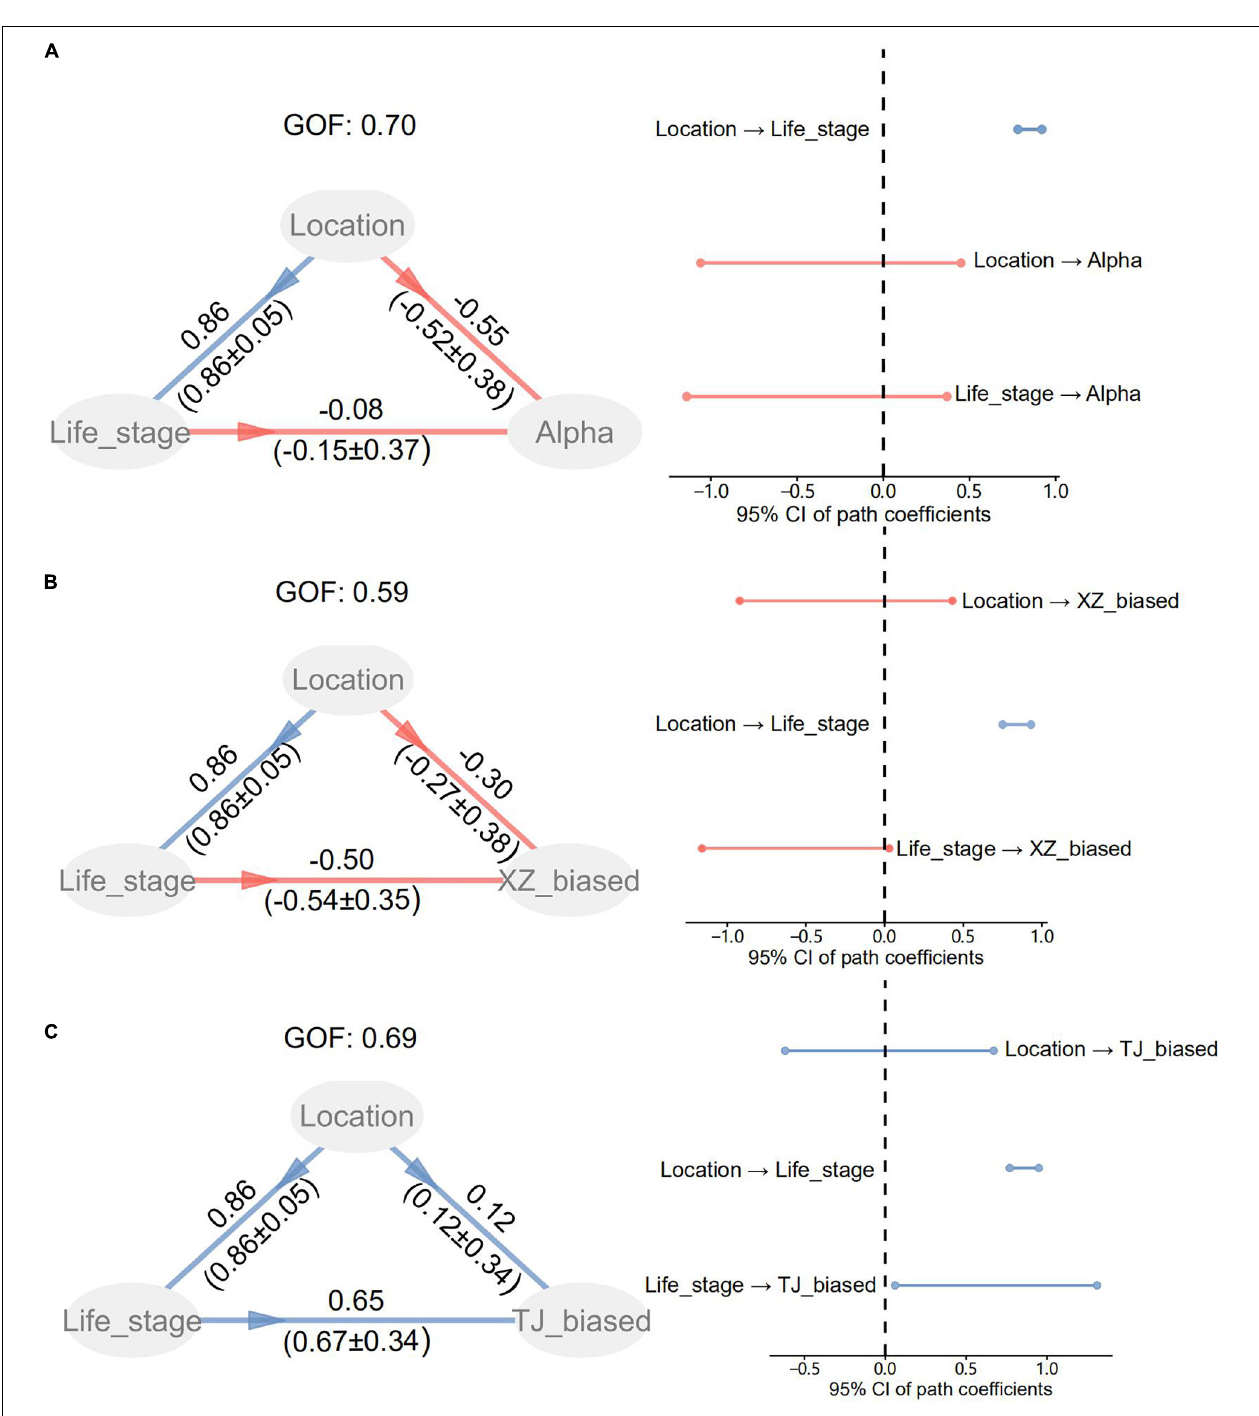
FIGURE 3 | Partial least squares path modeling (PLSPM) for life stage, location, and α diversity (A) or population-biased taxonomic compositions (B,C) . As for location factors, “1” was assigned to TJ and “0” to XZ. TJ_biased and XZ_biased represent taxa with a biased relative abundance to TJ and XZ, respectively. GOF is the goodness of fit index for accounting for the model quality. The original path coefficients and bootstrap values (mean ± SE) are shown along paths.